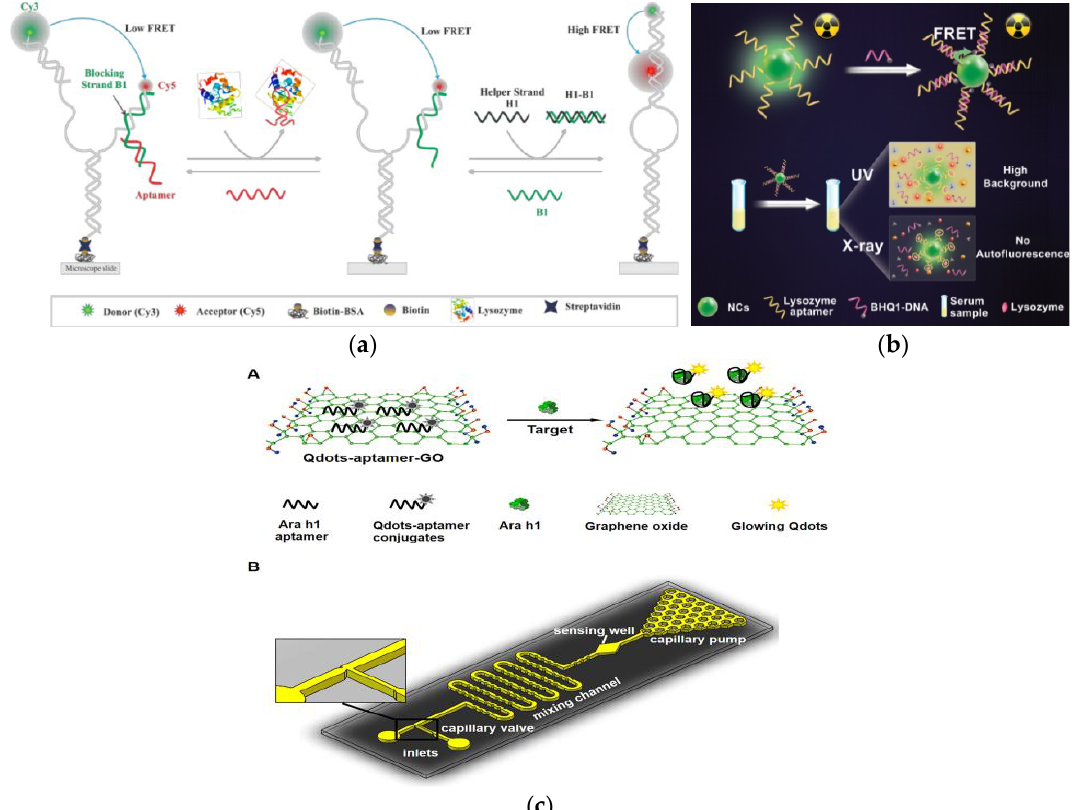
Figure 5. ( a ) Schematic of aptamer-based fluorescent biosensor for Lys detection. Reproduced with permission from [168]. Copyright sensors, 2020. ( b ) Schematic of aptamer sensor based on nanocrystal scintillator for detecting Lys without autofluorescence. Reproduced with permission from [170]. Copyright Analytical Chemistry, 2019. ( c ) A: Schematic of the Qdots-aptamer-GO quenching sensing principle; B: Schematic of the designed microfluidic chip. Reproduced with permission from [171]. Copyright Biosensors & Bioelectronics, 2016.